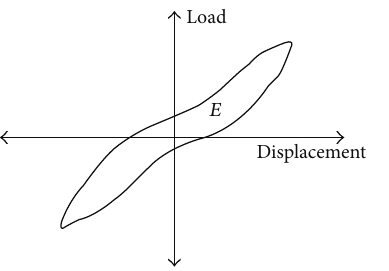
Figure 17: Energy dissipated per cycle definition.